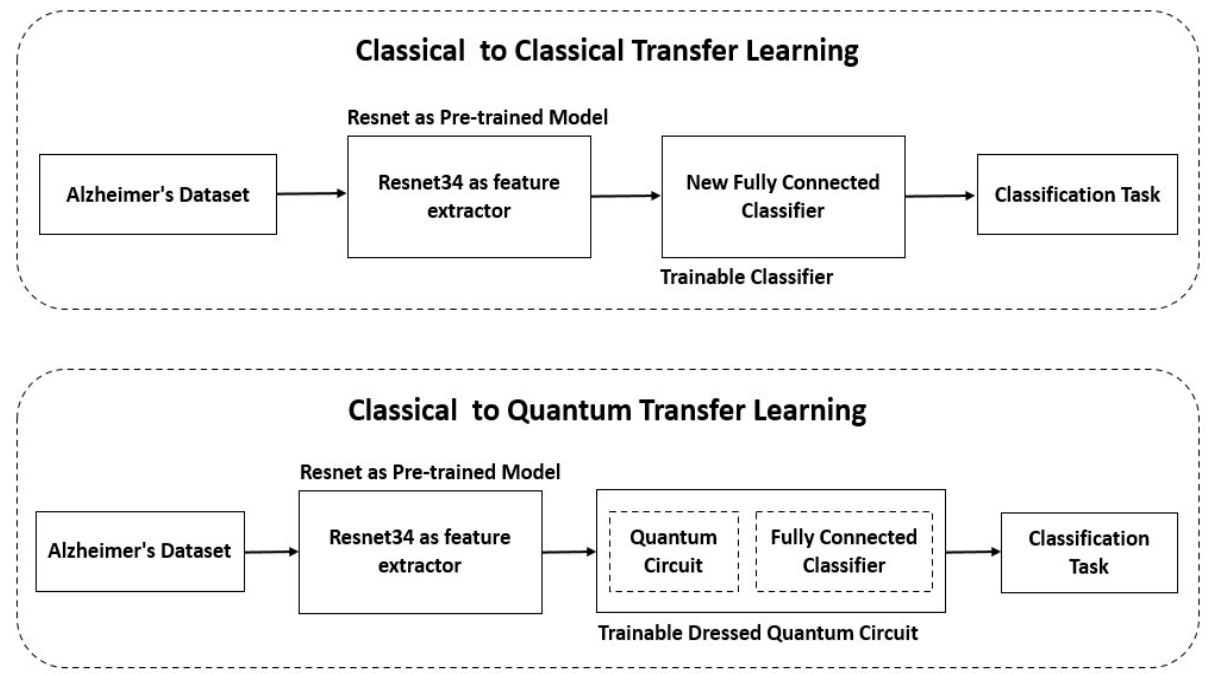
Figure 4. Illustration of hybrid classical to quantum transfer learning.